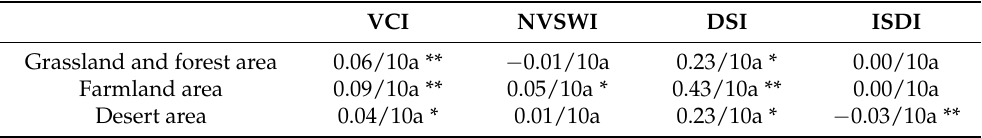
Figure 7. Temporal changes in ( a ) VCI, ( b ) NVSWI, ( c ) DSI and ( d ) ISDI in the grassland and forest area, and farmland area and desert area, over 1982–2020. Table 4. Temporal trends in VCI, NVSWI, DSI and ISDI in the grassland and forest area, and farmland area and desert areas, over 1982 − 2020.